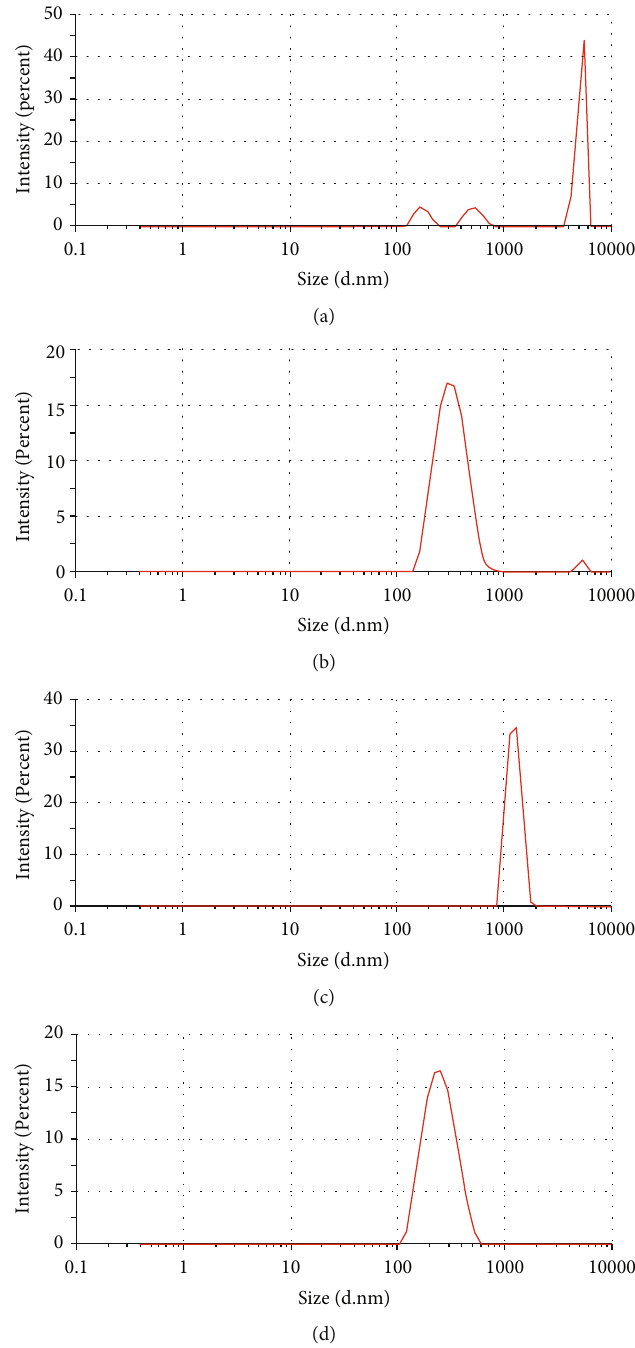
Figure 4: DLS measurements of (a) kaempferol, (b) NF-k, (c) combretastatin, and (d)